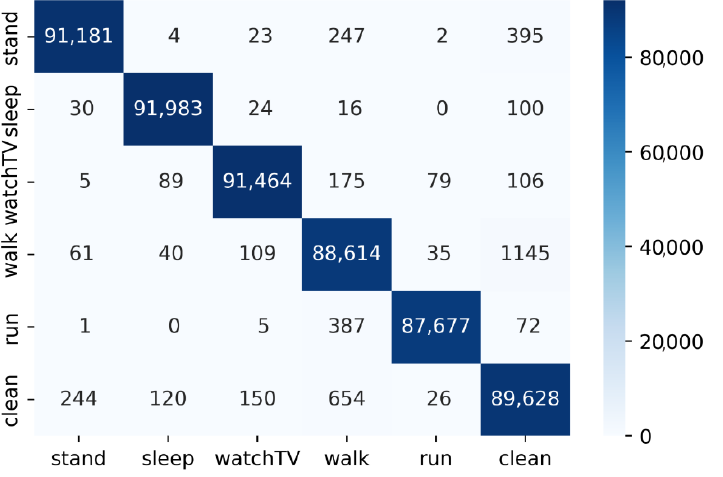
Table 4. Ablation experiments of the four attention models on the datasets without I.I.D. Model